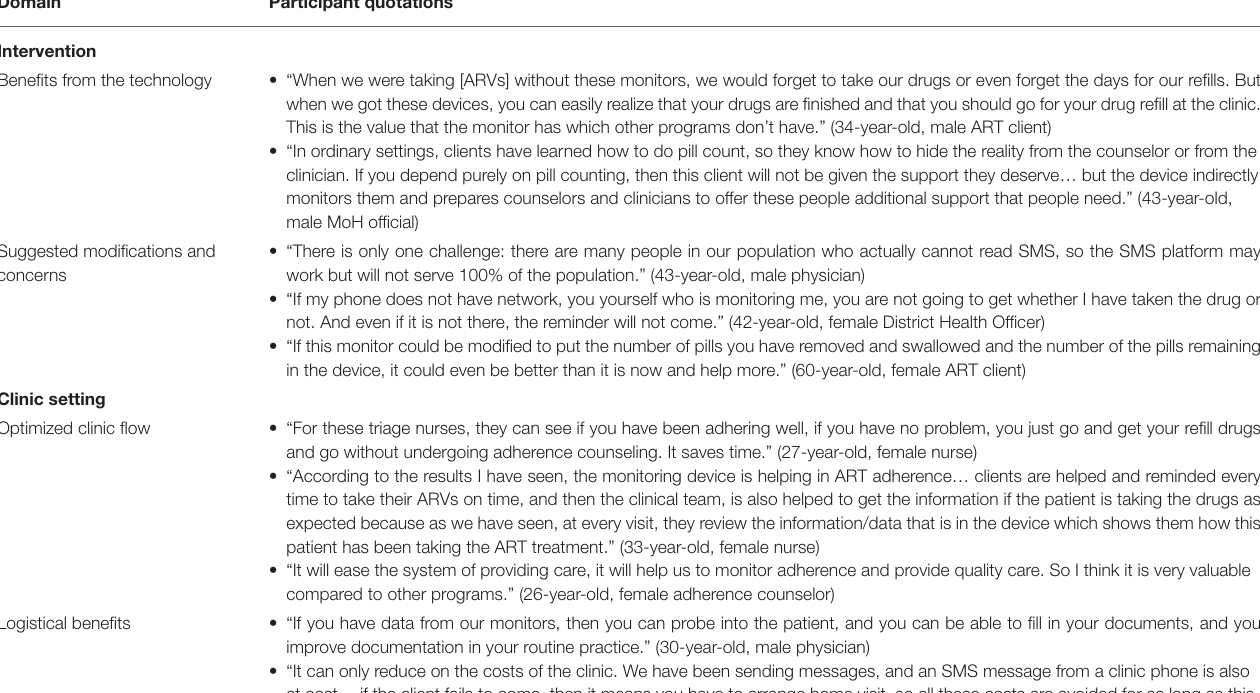
TABLE 4 | Participant quotations from qualitative interviews according to the CFIR.